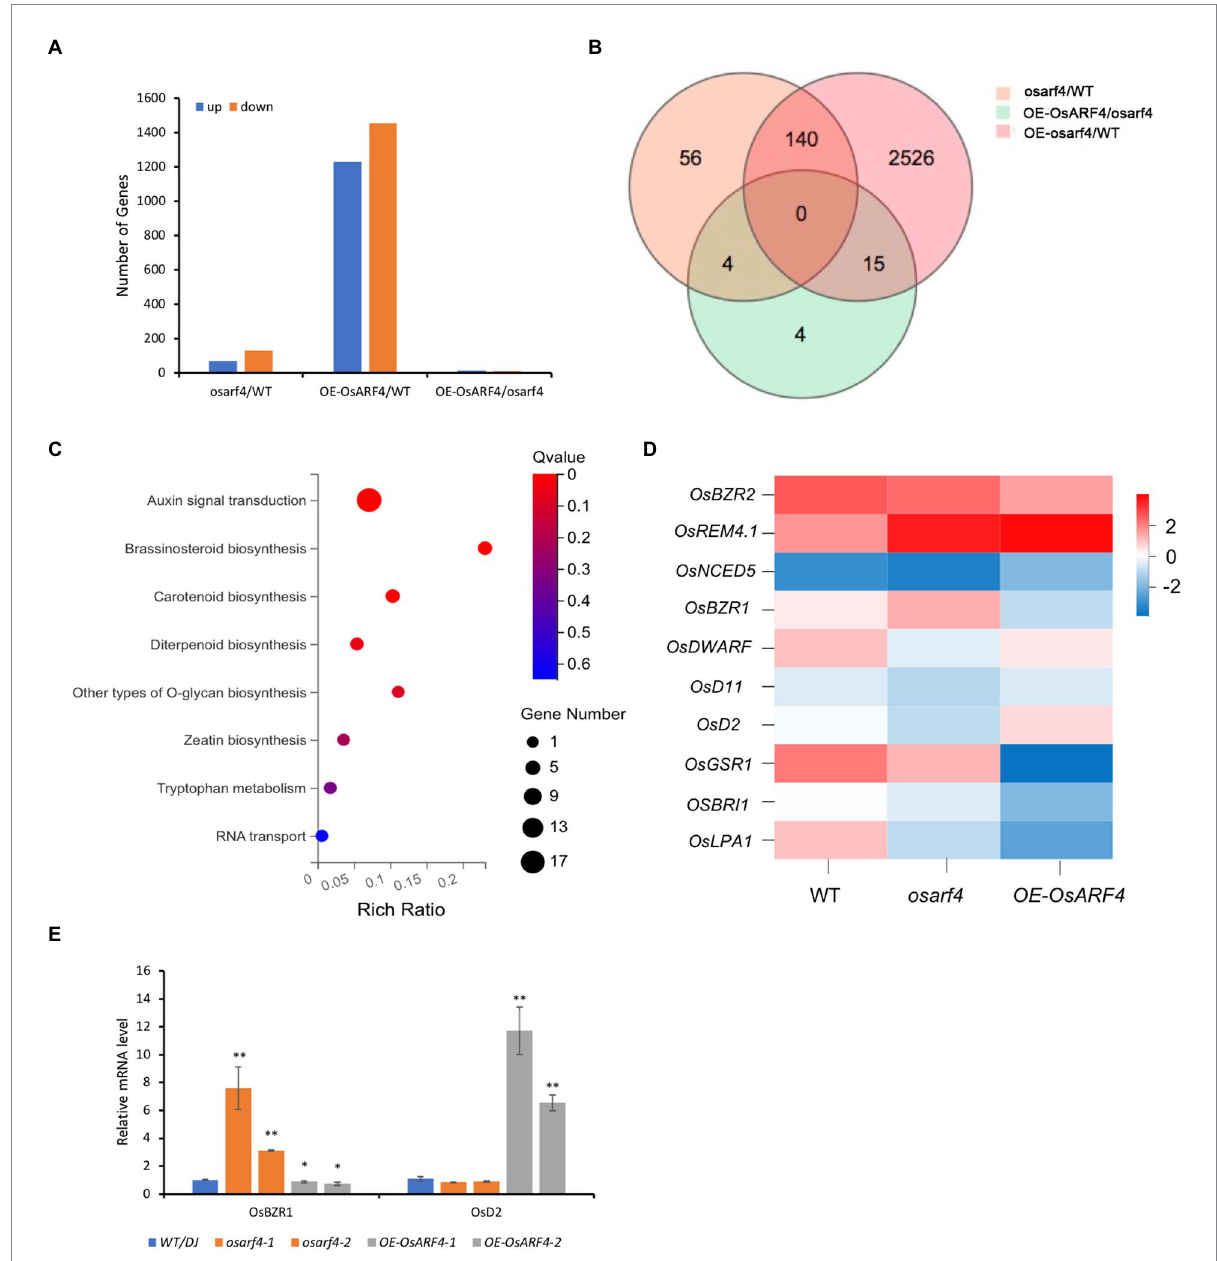
FIGURE 5 RNA-seq analysis of OsARF4 -modulated genes in rice LJs. (A) Numbers of DEGs in the LJs of WT/DJ versus osarf4 , WT/DJ versus OE-OsARF4, and osarf4 versus OE-OsARF4 . Blue columns represent up-regulated genes, and orange columns represent downregulated genes. (B) Venn diagram showing an overlap of DEGs in LJs in WT/DJ versus osarf4 , WT/DJ versus OE-OsARF4, and osarf4 versus OE-OsARF4 in LJs. (C) GO enrichment functional clustering of OsARF4 -modulated genes that were differentially expressed in the transcriptome. X-axis represents enrichment ratio. The size of bubbles represents the number of DEGs annotated to a certain GO term. The color represents enrichment significance value. (D) Heat map of the RNA-seq analysis revealed the expression patterns of selected genes during BR biosynthesis and signaling in WT/DJ, osarf4 mutant, and OsARF4 -overexpressing lines. (E) Relative expression of OsBZR1 and OsD2 in two osarf4 mutants and two OE-OsARF4 lines. Three individual biological replicates were taken for each experiment. * p < 0.05 and ** p < 0.01 indicate significant differences compared with WT/DJ using Student’s t